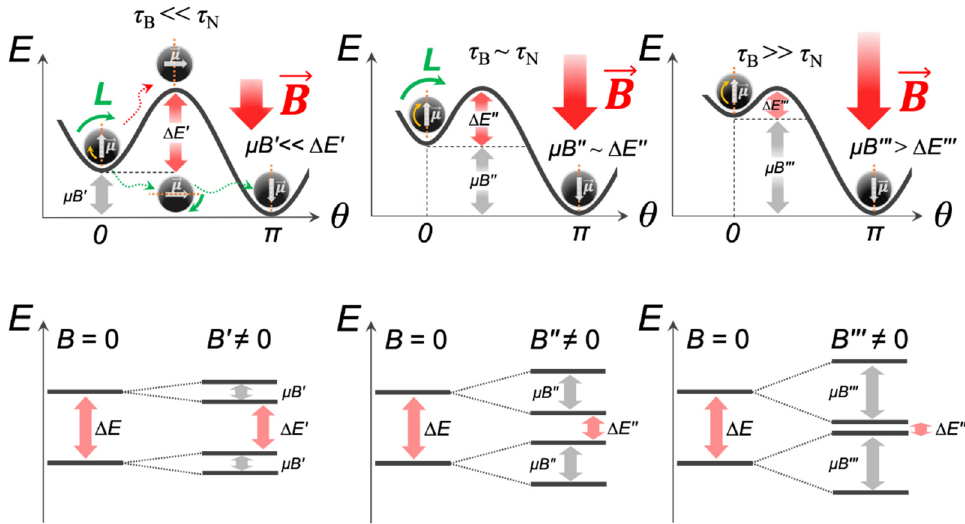
Figure 3. An increase in the amplitude of an external MF leads to a decrease in the value of the anisotropy energy barrier ∆ E ′ > ∆ E ″ > ∆ E ‴ and gradual dominance of the Néel regime. L denotes the magnetic torque.